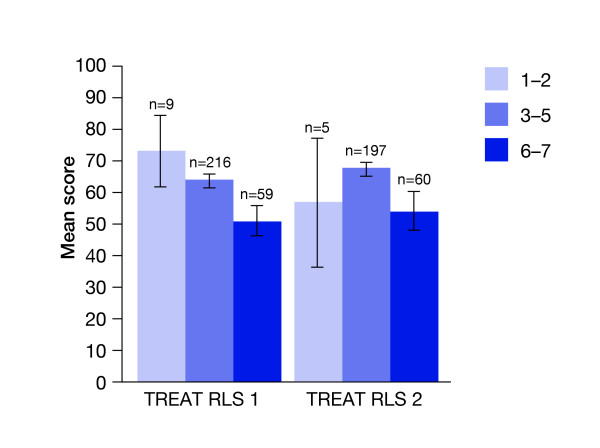
Clinical validity. Comparison of RLSQoL overall life impact scores at baseline among CGI-S groups. CGI-S subgroups 1–2 include normal, not at all ill and borderline ill patients; subgroups 3–5 include mild, moderate, and markedly ill patients; and subgroups 6–7 include severely ill, and the most extremely ill patients. p < 0.0003 (Kruskall-Wallis test comparing all three subgroups) and p < 0.000.1 (Mann-Whitney-Wilcoxon test comparing subgroups 3–5 with 6–7) for comparisons of RLSQoL overall life impact scores among collapsed CGI-S subgroups in both TREAT RLS 1 and 2; p = not significant (Mann-Whitney-Wilcoxon test comparing subgroups 1–2 with 3–5). RLSQoL = RLS Quality of Life questionnaire. CGI-S = Clinical Global Impression 'Severity of Illness'.